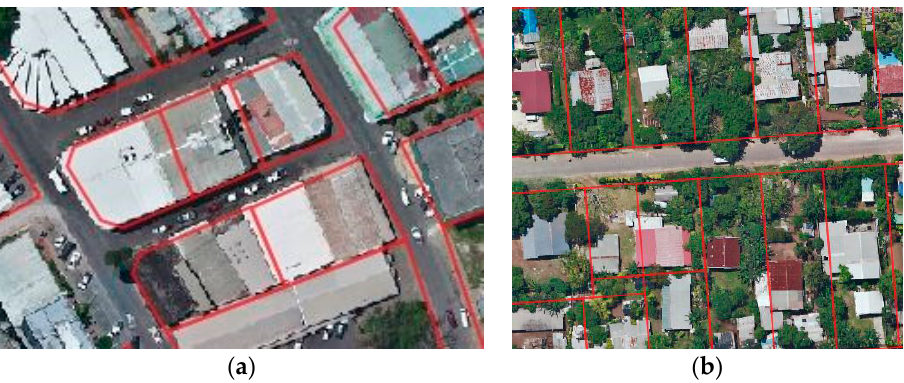
Figure 6. The illustration of buildings arrangement with cadastral boundaries in ( a ) region 1—urban, and ( b ) region 2—suburban.